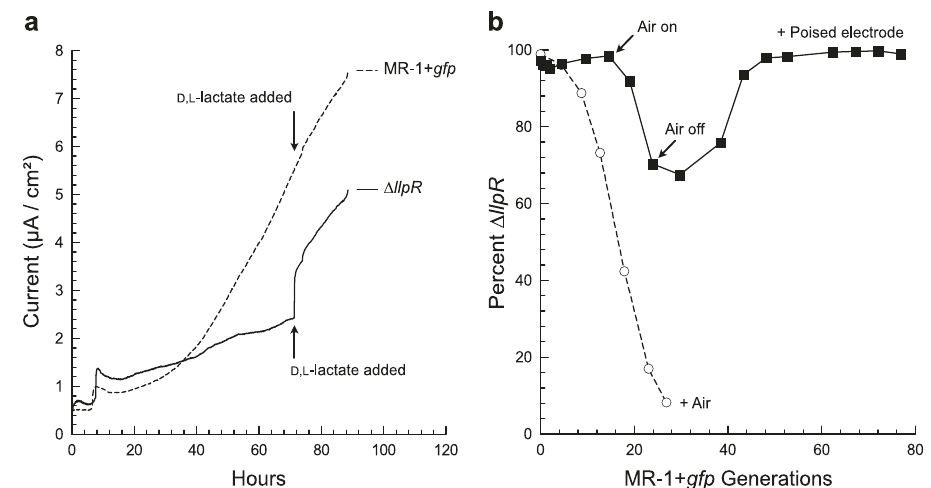
Fig. 4 Alternative hypothesis testing. a The carbon source determines the metabolic rate of strain Δ llpR (solid line). Adding D , L -lactate provides a second carbon source, D -lactate, that is utilized preferentially and equally by both strains. The immediate increase in current from strain Δ llpR (but not from strain MR-1 + gfp , represented by a dashed line) demonstrates that it is limited by its capacity to metabolize L -lactate during growth on electrodes. Data shown is representative from N = 2 experimental replicates. b Letting air into an anaerobic bioreactor (black squares and solid line) provides planktonic cells with O 2 as a terminal electron acceptor. The ensuing competition causes a decline in the relative abundance of strain Δ llpR . Once anaerobic conditions have been re-established, strain Δ llpR returns to its original frequency, re fl ecting migration from a bio fi lm that is resilient to such perturbations. For comparison, strain Δ llpR is at a strong disadvantage during competition in an aerobic planktonic culture (white circles and dashed line). Data shown represent a single